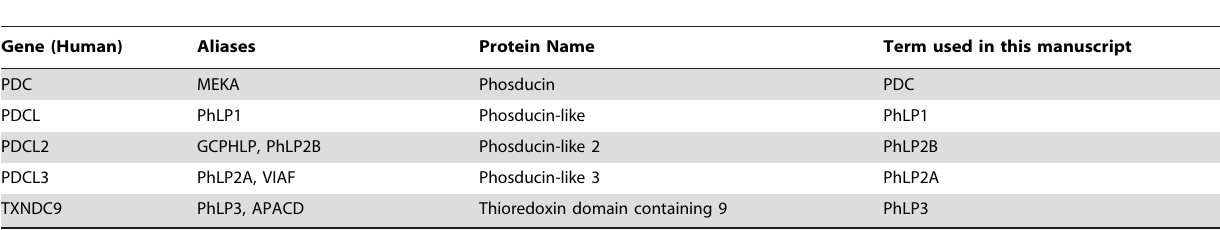
Table 1. The nomenclature used for the Phosducin like proteins (PLPs) discussed in this manuscript.